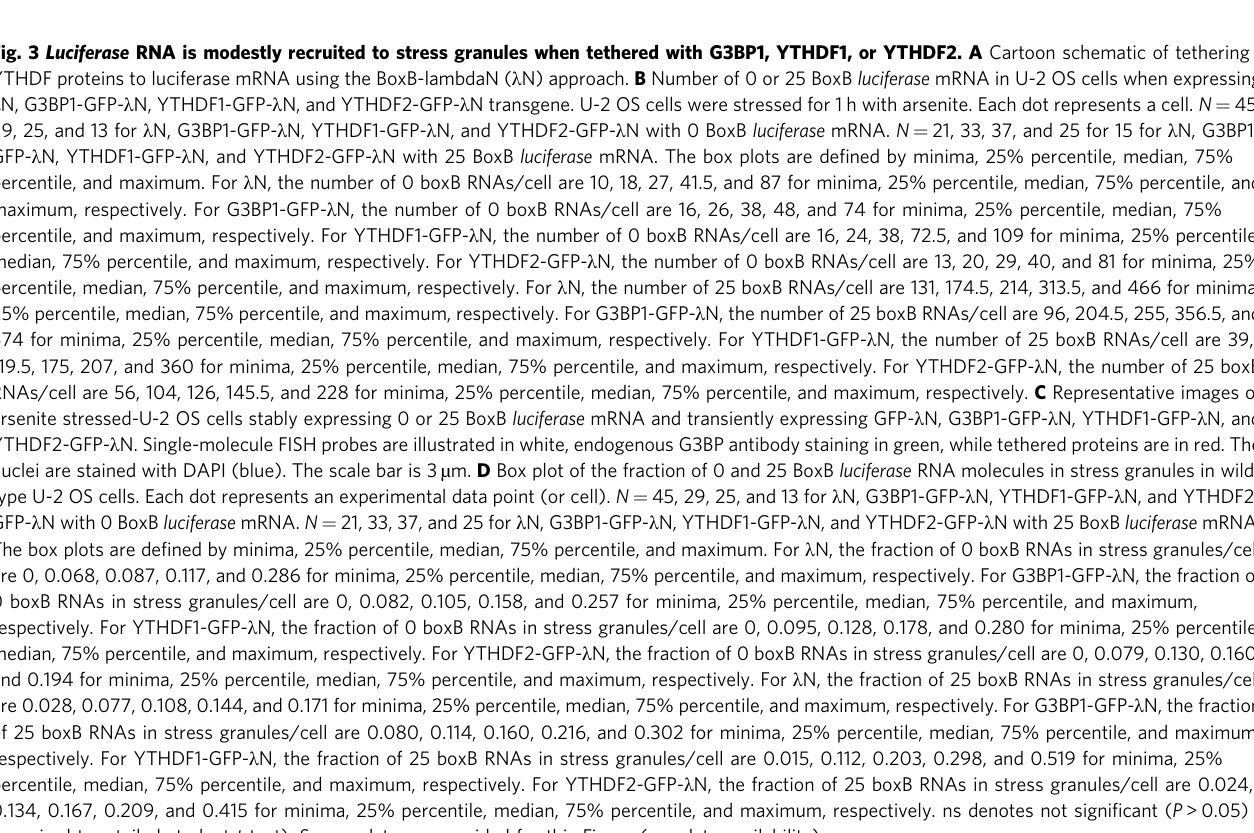
Fig. 3 Luciferase RNA is modestly recruited to stress granules when tethered with G3BP1, YTHDF1, or YTHDF2. A Cartoon schematic of